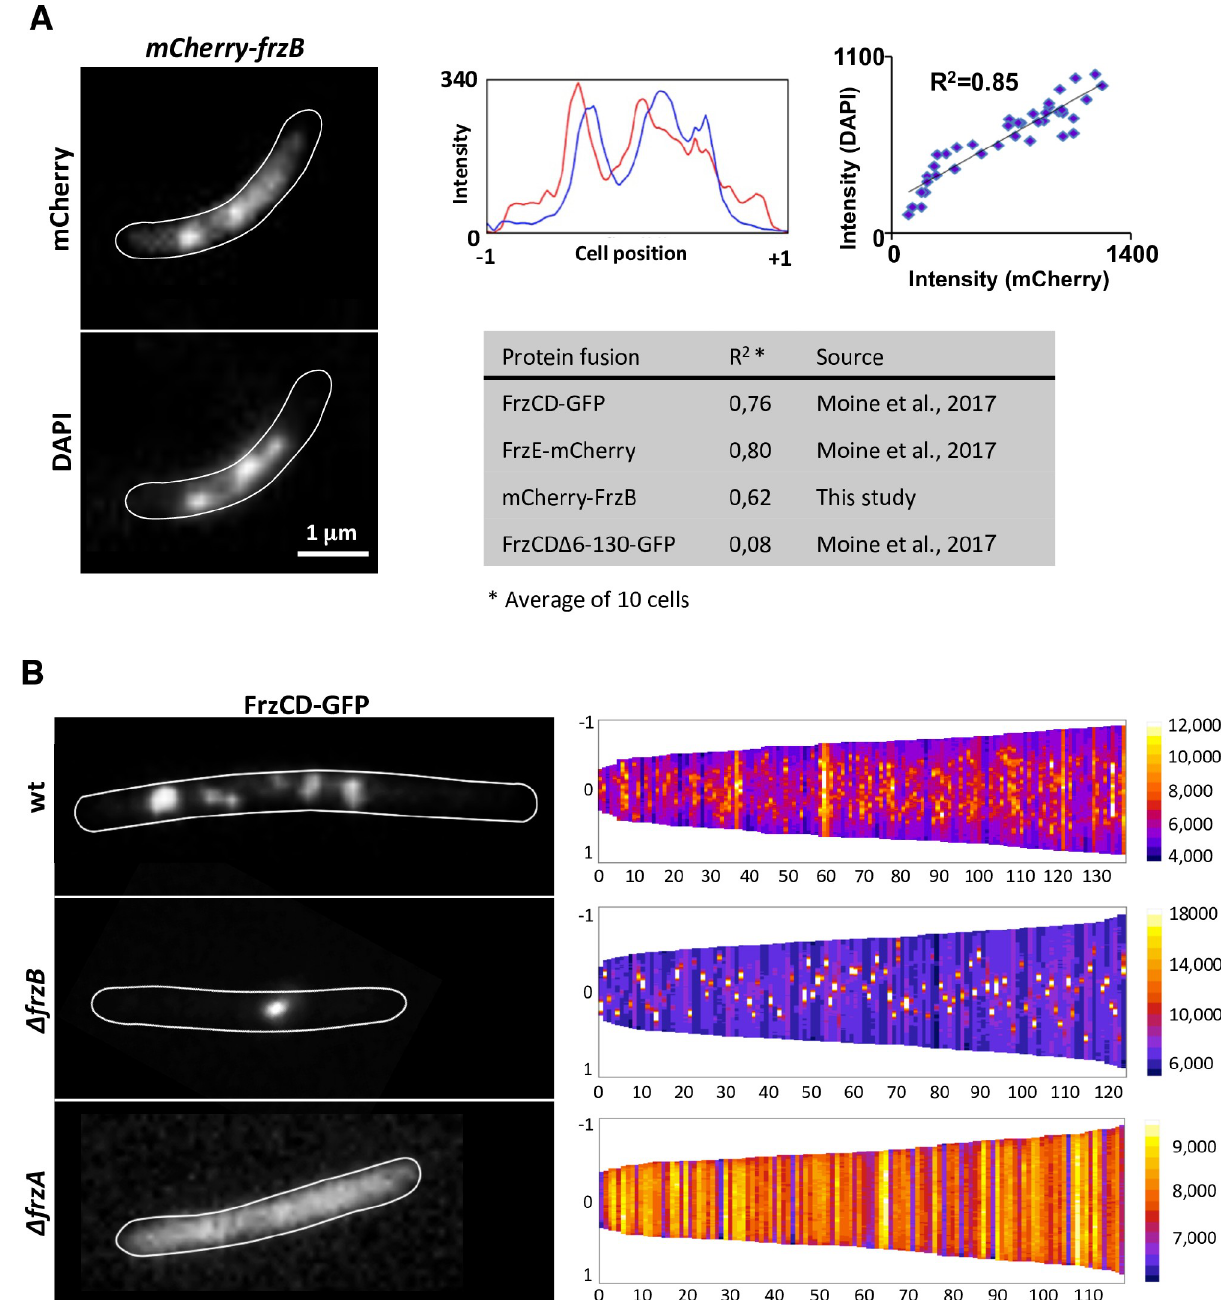
Fig 4. Localization of FrzB-mCherry in M . xanthus cells. (A) (Left) Micrographs of mCherry-frzB cells stained with the DNA DAPI stain. (Middle) mCherry (red) and DAPI fluorescence (blue) profiles are shown with the fluorescence intensity (arbitrary units) represented on the y -axis and the cell length positions with -1 and +1 indicating the poles, on the x- axis. The cell boundaries were drawn manually from the phase-contrast images. (Right) Plot of correlation coefficients of DAPI and mCherry localization. R 2 values > 0.5 indicate significant correlations. The table compares the R 2 values between the indicated fluorescent fusion and DAPI staining. (B) (Left) Fluorescence micrographs of the indicated M . xanthus strains carrying FrzCD- gfp fusions. The cell boundaries were drawn manually from the phase-contrast images. (Right) For each indicated strain, more than 120 cells ( x axis) from at least two biological replicates are represented as lines and ordered according to their length (pixels) in demographs. The GFP fluorescence intensity along the cell body is represented as colored pixels at the corresponding cell position (from -1 to +1 on the y axis). “0” is the cell center. On the right, a scale indicates the fluorescence intensity and the corresponding